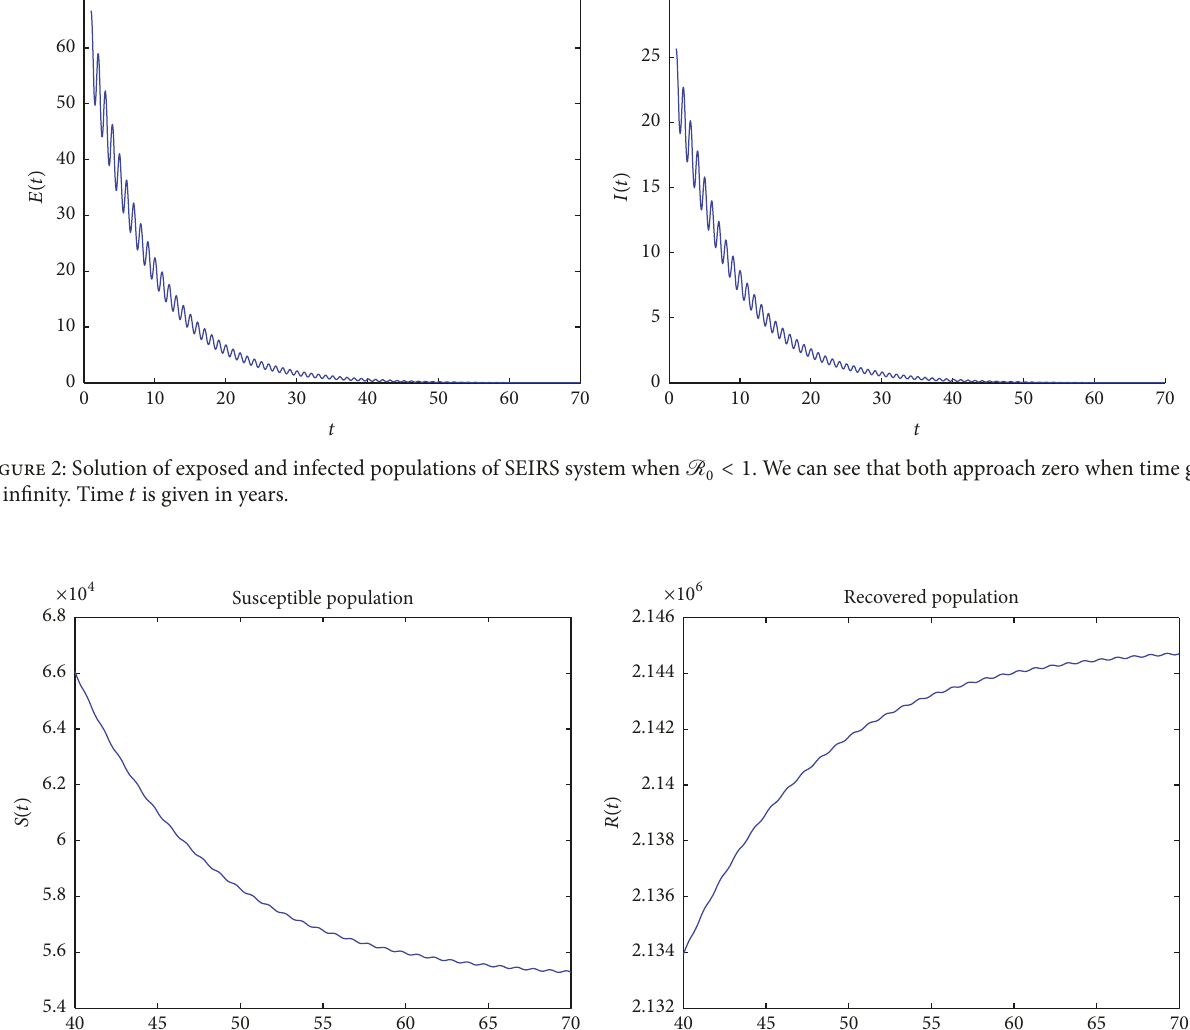
Figure 3: Solution of susceptible and recovered populations of SEIRS system when R 0 < 1 . We can see that 𝑆 approaches ̂𝑅(𝑡) = 𝑁 − ̂𝑆(𝑡) and 𝑅 approaches . Time 𝑡 is given in